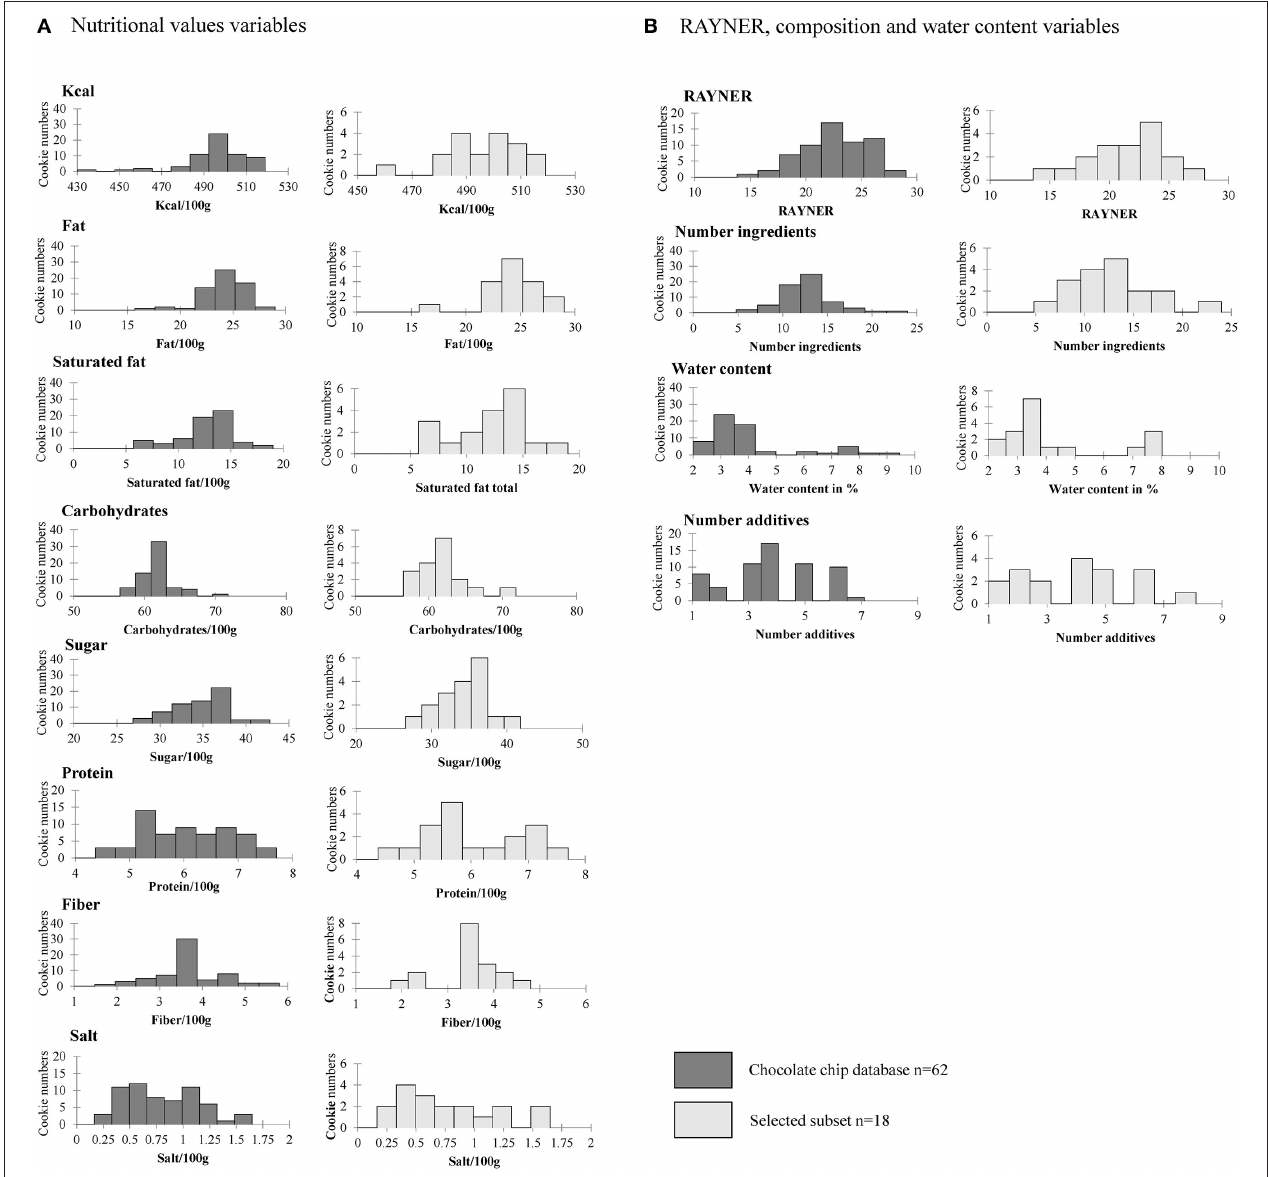
FIGURE 8 | Comparison of 12 nutrition, composition and water content variables among chocolate chip cookies and the selected subset based on distributions with (A) nutritional values variables and (B) Rayner score, composition, and water content